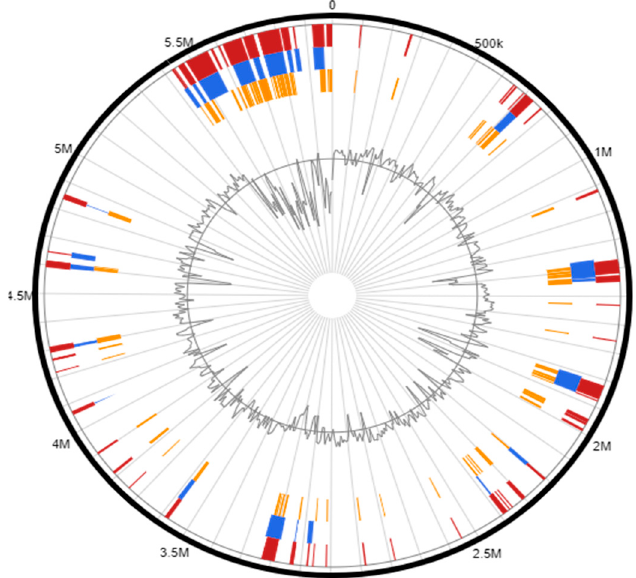
Figure 1. Circular map generated by IslandViewer4 depicting the location of genomic islands within the genome of Serratia sp. HRI. Orange bars represent GIs identified via the SIGI ‐ HMM genomic island prediction software, blue bars are GIs identified via IslandPath ‐ DIMOB program, and the integrated GIs identified via all programs used are represented by red bars. Adapted from IslandViewer4 [15].